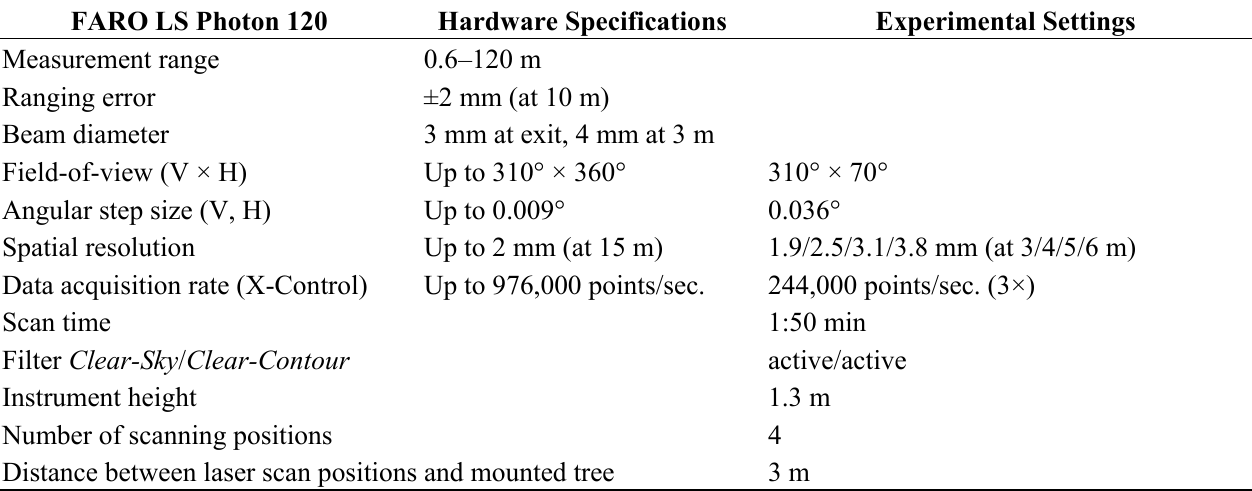
Table 2. Technical specification and experimental settings of the FARO LS Photon